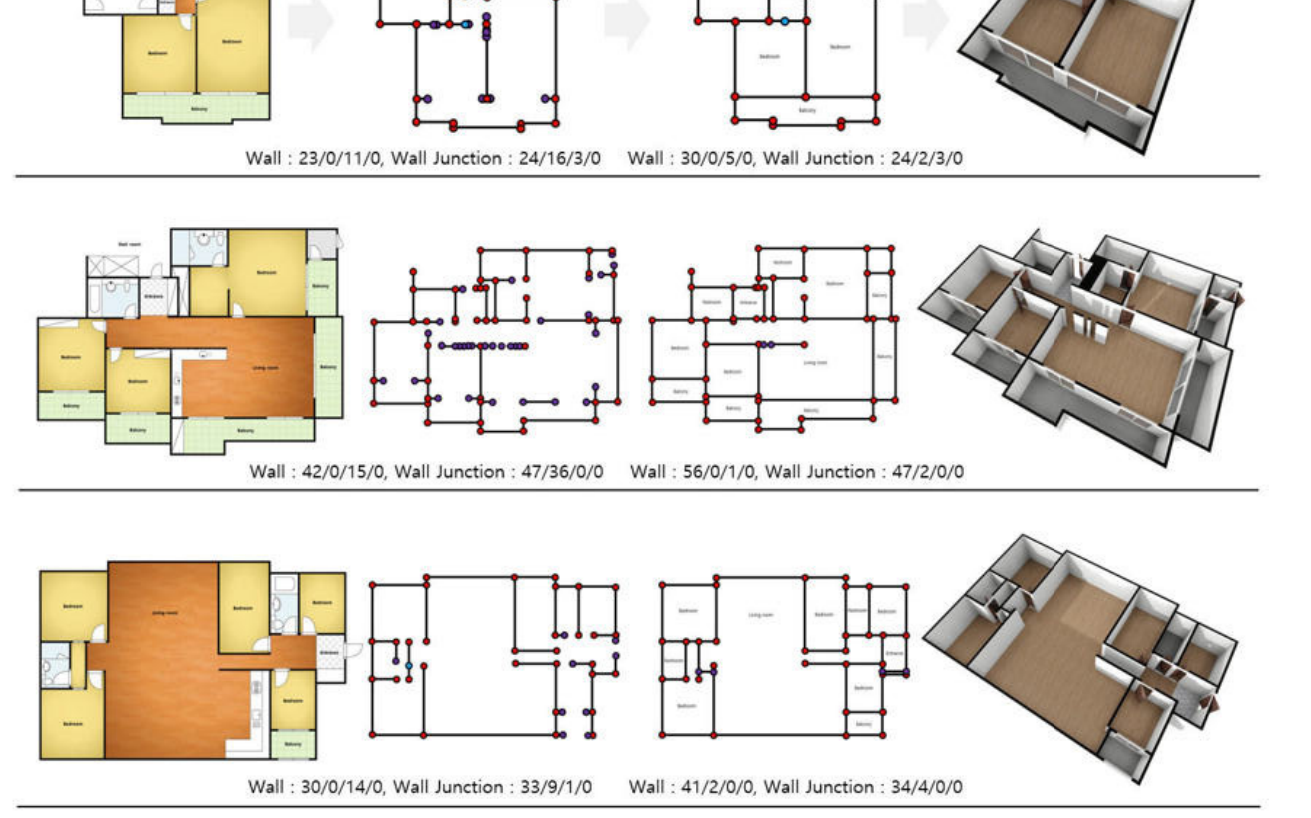
Figure 11. Result of generating various 2D Floorplan images. From the left, input data, data based methods result (TP/FP/FN/TN), ensemble method results (TP/FP/FN/TN), output